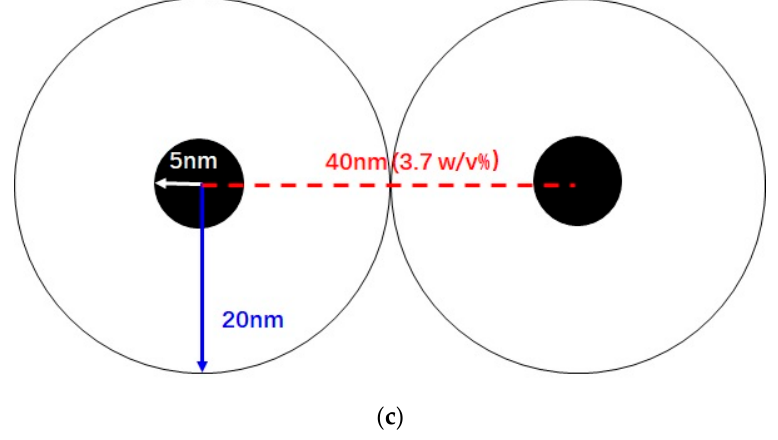
Scheme 2. Cartoon of the size and distance of micelles (solid small circle representing core and unfilled large circle representing corona) at ( a ) concentration for total overlap of corona (15 w/v%); ( b ) concentration for partial overlap (12 w/v%); and ( c ) overlap concentration (3.7 w/v%). The overlapping fraction f 1 is plotted as a function of concentration in Figure 2 (left y -axis). The value of f 1 is null until 3.7 w/v%, then increases smoothly beyond that, suggesting that below a certain threshold no network can form because the micelles do not overlap and, hence, cannot form any intermicellar connection [32–34].